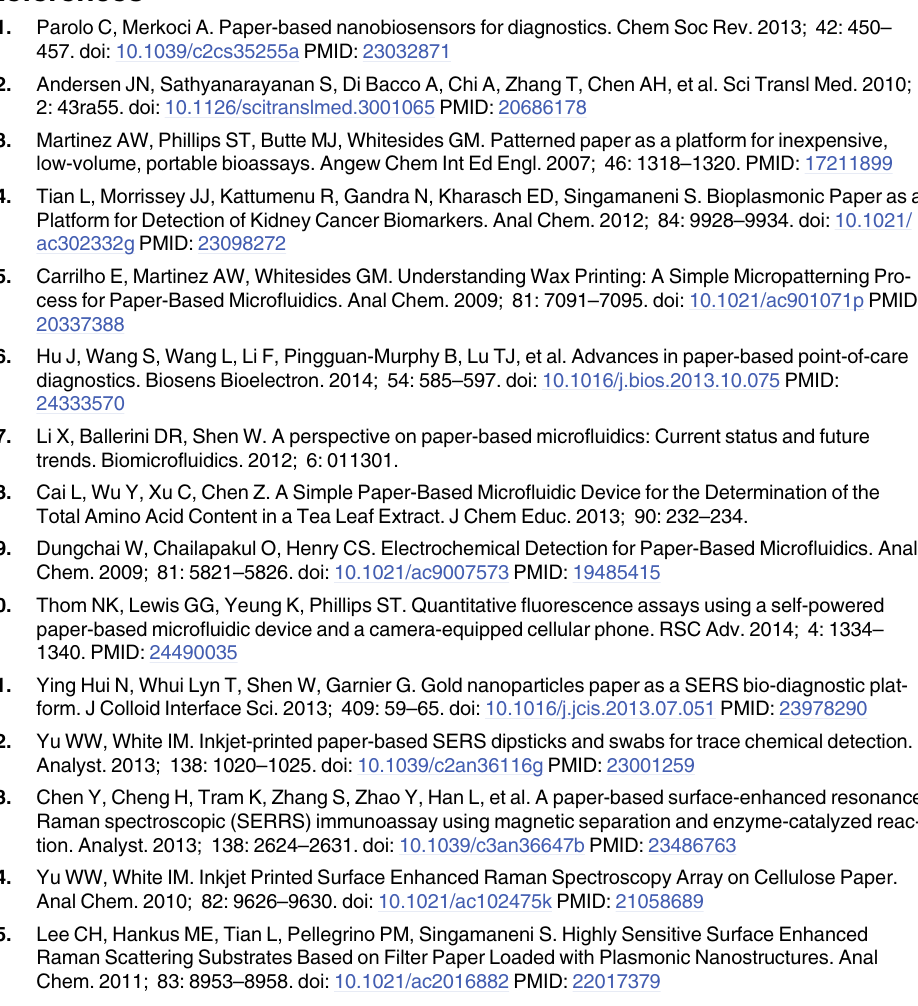
S1 Table. Measured S/N as the number of modulation cycles (5 – 30) and modulation ampli- tude ( Δλ ) were altered for different exposure times: (a) 3s exposure time, (b) 4s exposure time and (c) 5s exposure time. Measurements are an average of 5